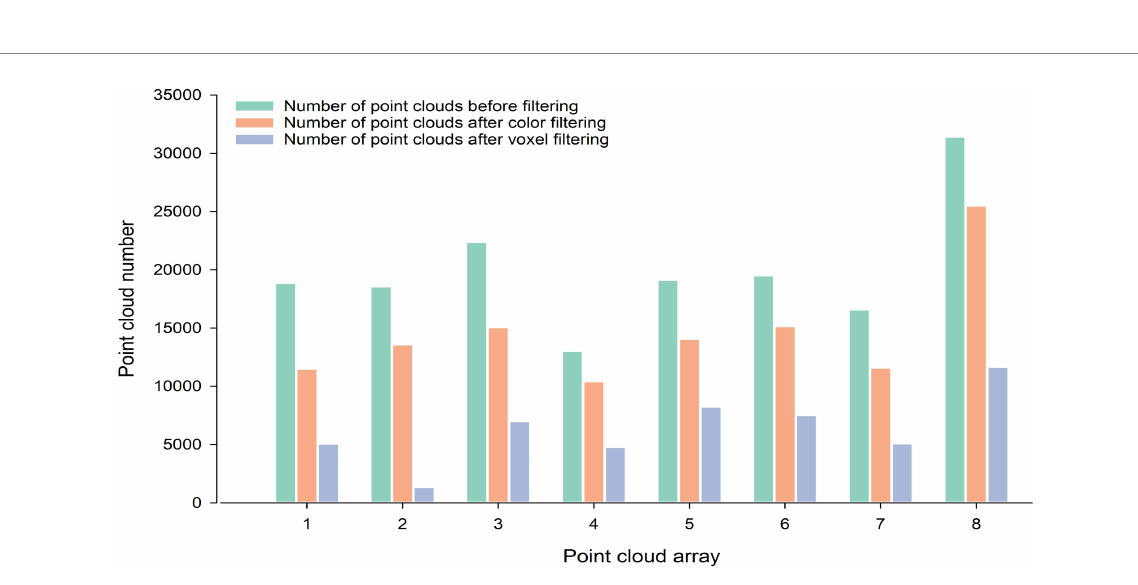
algorithmic measurements. The plant height, leaf length, relative leaf